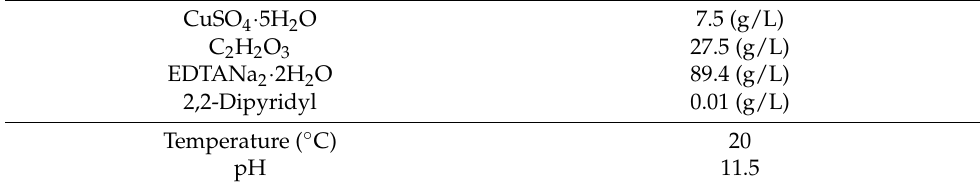
Table 2. Formula and conditions for electroless Cu